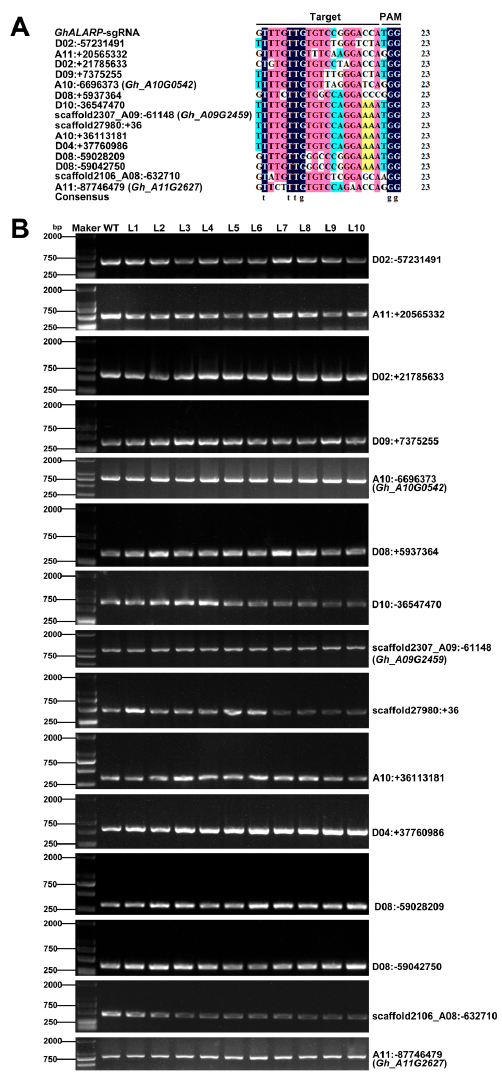
Figure 4. Analysis of the 15 potential off-target sites in the transgenic lines with verified editing in GhALARP . ( A ) Alignment of the 15 putative off-target sites and the GhALARP -sgRNA sequence; ( B ) PCR amplification results of the DNA sequences containing the predicted off-target. From the top to the bottom panels, D02: − 57231491 (572 bp), A11: +20565332 (482 bp), D02: +21785633 (574 bp), D09: +7375255 (352 bp), A10: − 6696373 ( Gh_A10G0542 ) (748 bp), D08: +5937364 (364 bp), D10: − 36547470 (664 bp), scaffold2307_A09: − 61148 ( Gh_A09G2459 ) (940 bp), scaffold27980: +36 (476 bp), A10: +36113181 (340 bp), D04: +37760986 (563 bp), D08: − 59028209 (317 bp), D08: − 59042750 (367 bp), scaffold2106_A08: − 632710 (445 bp), and A11: − 87746479 ( Gh_A11G2627 ) (759 bp). Lanes 1–10 represent ten independent transgenic cotton plants (L1 to L10). Lanes WT is the PCR product from the non-transformed wild-type plant YZ-1 (negative control for the target